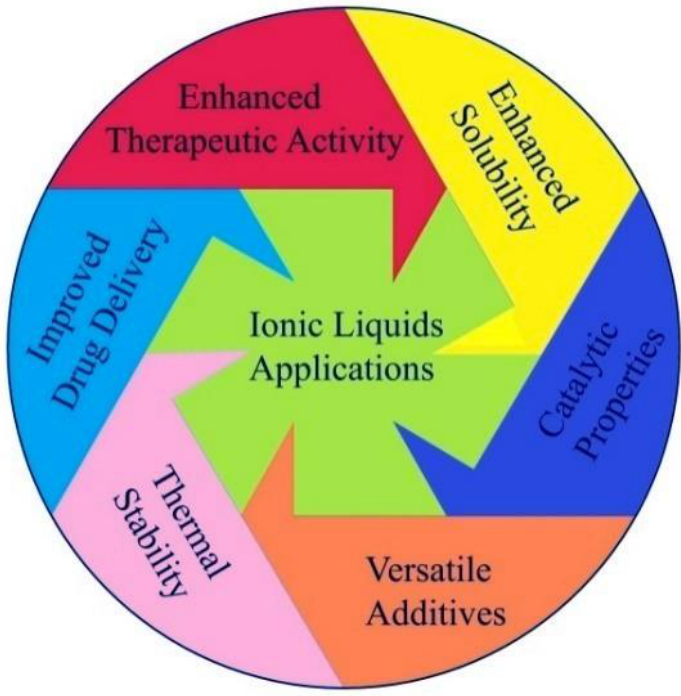
Figure 1. Representation of the general applications of ILs.